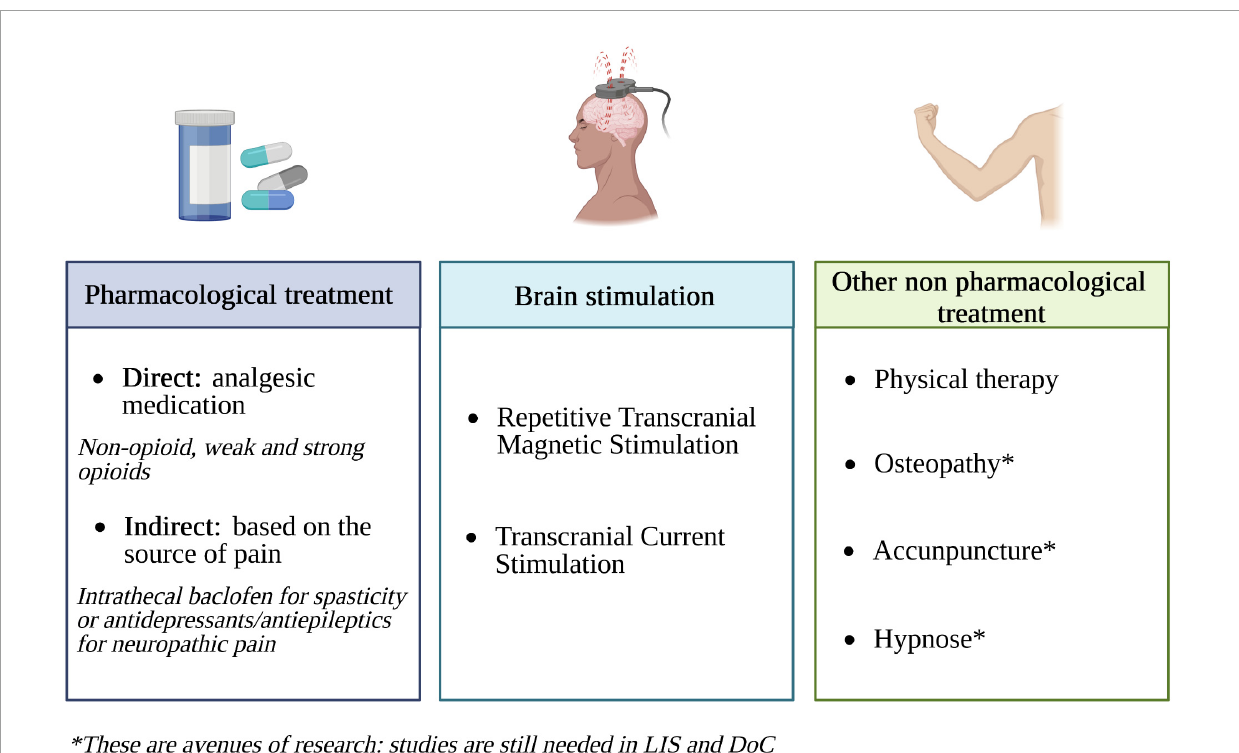
FIGURE4 Pain treatment options in DoC and LIS patients (created with BioRender.com). Based on Posadzki and Ernst (2011), Klein et al. (2015), Chatelle et al. (2016), Vickers et al. (2018), Rice et al. (2019), Bicego et al. (2021), and de Pedro Negri et al.